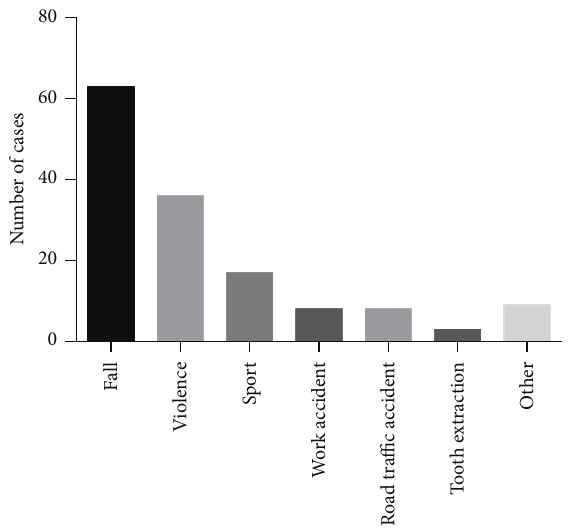
Figure 2: Numbers of patients by cause of fracture.